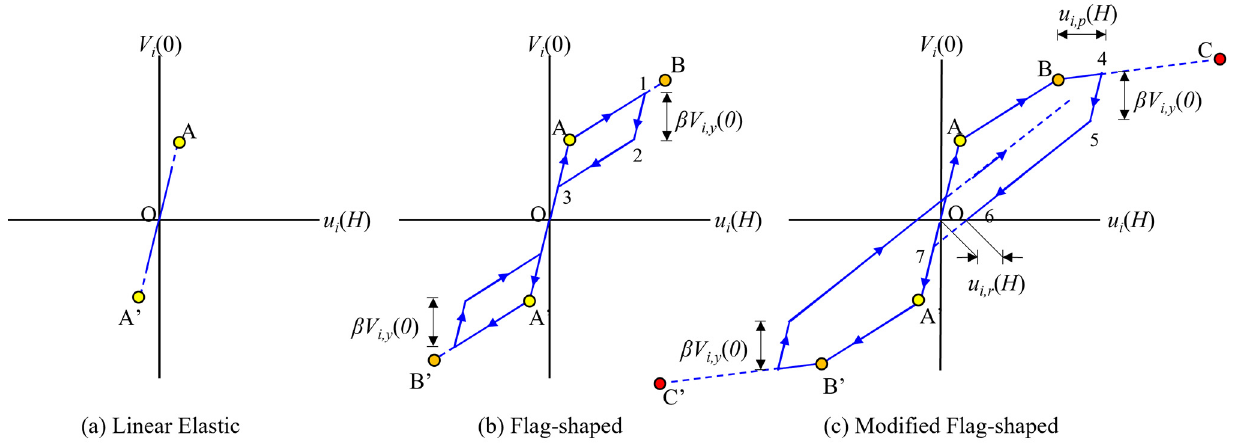
Figure 9. Generalized full cyclic responses.